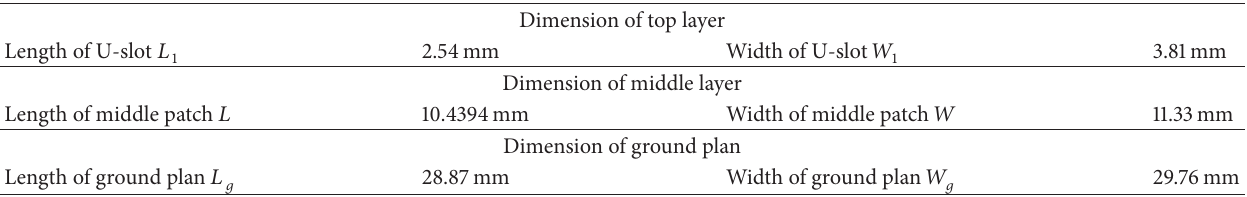
Table 1: Dimension of proposed